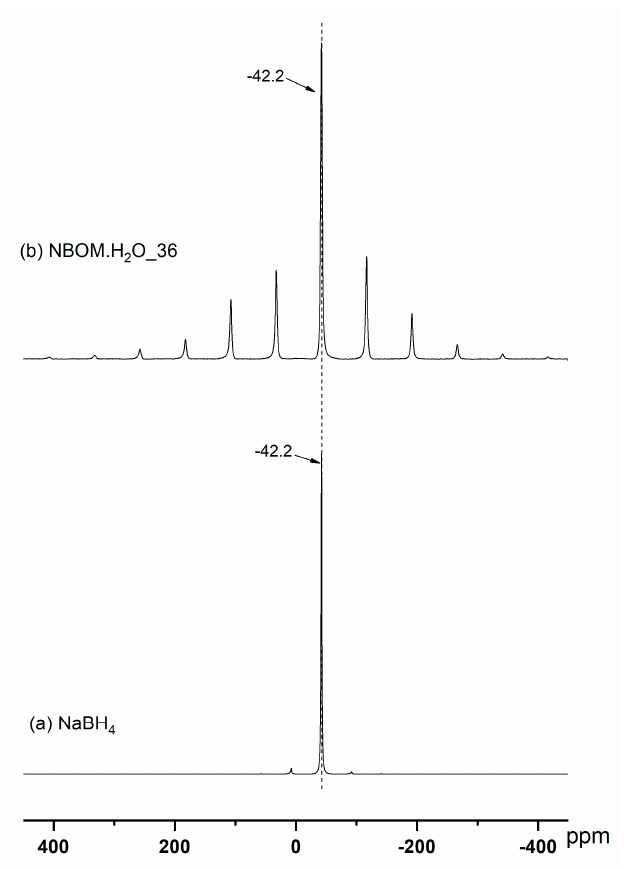
Figure 7. NMR spectra of NaBH 4 and NBOM · H 2 O milled for 36 h under 1 bar Ar.